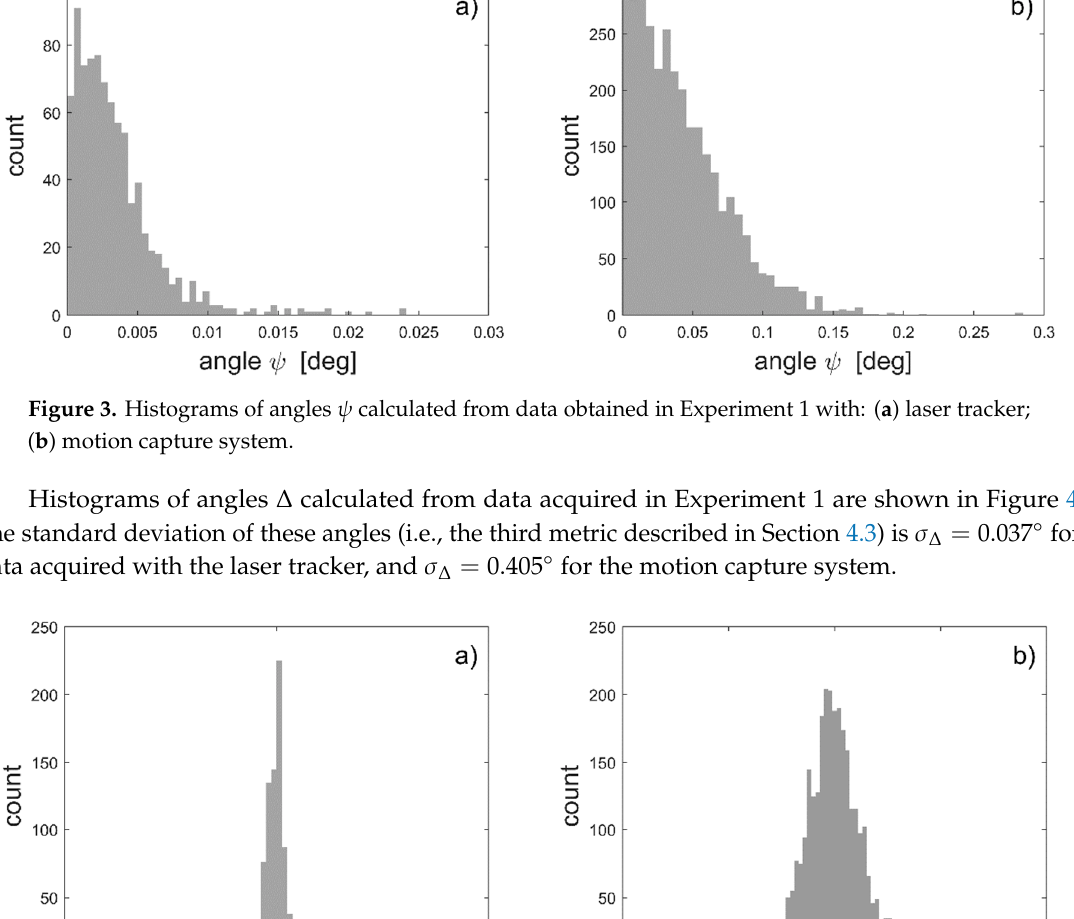
Figure 2. Histograms of the distances between the three markers measured in Experiment 1 by the laser tracker (left column) and the motion capture system (right column).